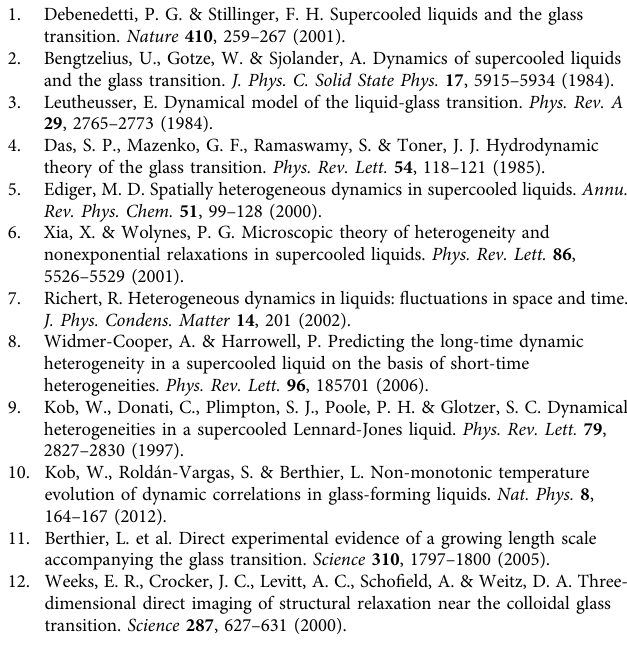
behaviors indicate distinct relaxation mechanisms at the different microscopic length scales, and reveal the characteristic spatial length of ≈ 2.6 Å: Above 2.6 Å, the relaxation is dominated by the inter-particle correlation of the nitrate ions; while below 2.6 Å, the relaxation exhibits localized feature manifested as tempera- ture independent heterogeneity and more Arrhenius-like beha- vior, due to the stabilization mechanism of the Coulombic interaction between nitrates and cations.